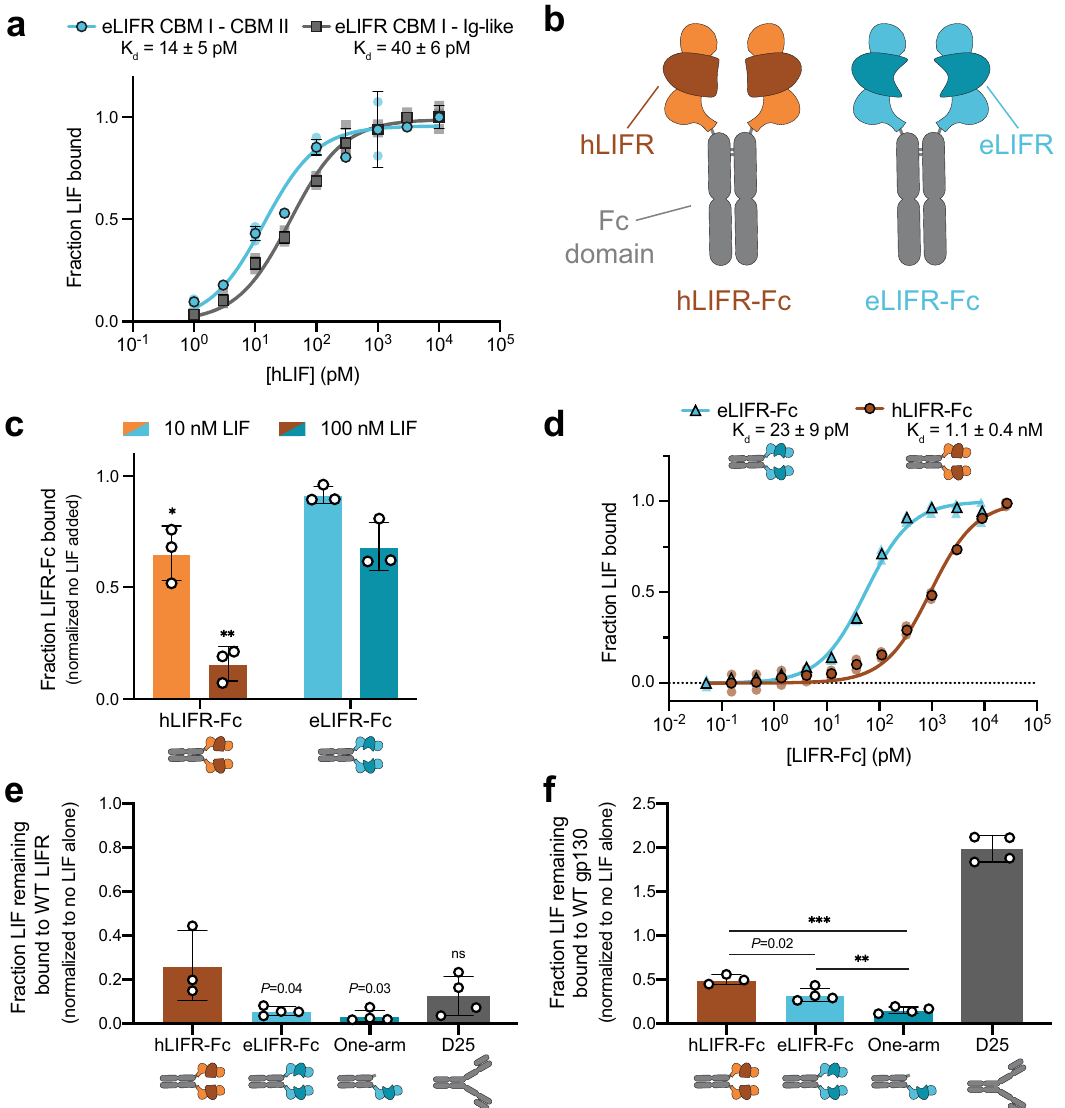
Fig. 3 eLIFR-Fc is a more potent LIF inhibitor than hLIFR-Fc. a Yeast-displayed eLIFR containing the CBM I – Ig-like – CBM II domains (blue circles) has a slightly higher af fi nity for LIF-His than eLIFR CBM I – Ig-like domains (gray squares). Data are the mean ± SD of triplicate measurements. Data from individual experiments are shown as faint symbols. b Schematic of hLIFR-Fc and eLIFR-Fc. The three N-terminal domains, CBM I – Ig-like – CBM II, are fused to an hIgG1 Fc-domain, with the engineered Ig-like domain shown in dark teal for eLIFR-Fc. c Versus hLIFR-Fc, eLIFR-Fc remains more strongly bound to yeast-displayed LIF after overnight incubation with soluble LIF competitor, indicating a slower off-rate. * P = 0.024, ** P = 0.0024 versus the corresponding hLIFR-Fc condition, two-tailed unpaired Student ’ s t test. Data are mean ± SD ( n = 3). d KinExA data showing that recombinant eLIFR-Fc (blue triangles) has higher af fi nity to soluble hLIF-His than hLIFR-Fc (brown circles). Data are the mean of duplicate measurements. Data from individual experiments are shown as faint symbols. e hLIFR-Fc, eLIFR-Fc (bivalent and one-arm), and D25 antibody compete LIF away from WT LIFR. ns not signi fi cant, P = 0.03 for one-arm eLIFR-Fc and P = 0.04 for eLIFR-Fc versus hLIFR-Fc, two-tailed unpaired Student ’ s t test. f Both hLIFR-Fc and eLIFR-Fc (bivalent and one-arm) compete LIF away from WT gp130, but the D25 mAb does not and appears to increase binding, perhaps due to complex stabilization or more avid LIF binding. P = 0.02, ** P = 0.006, or *** P < = 0.0002 versus hLIFR-Fc or eLIFR-Fc (as indicated), two-tailed unpaired Student ’ s t test. For e and f , data are mean ± SD ( n ≥ 3 independent